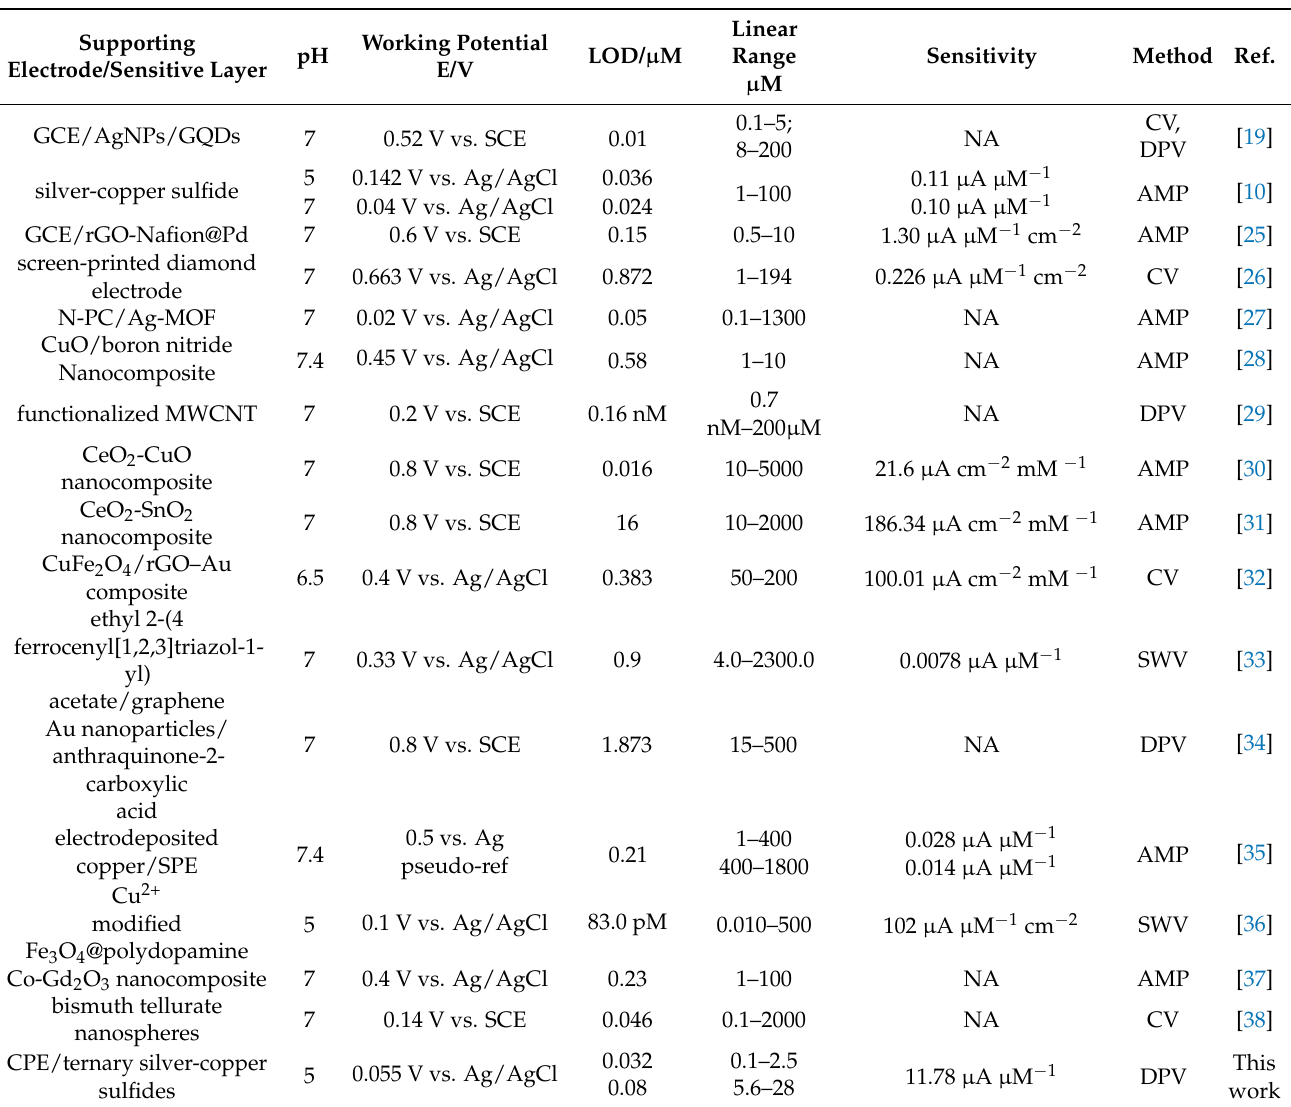
Table 1. Comparison of the electroanalytical performance of electrodes modified with various materials, for determination of